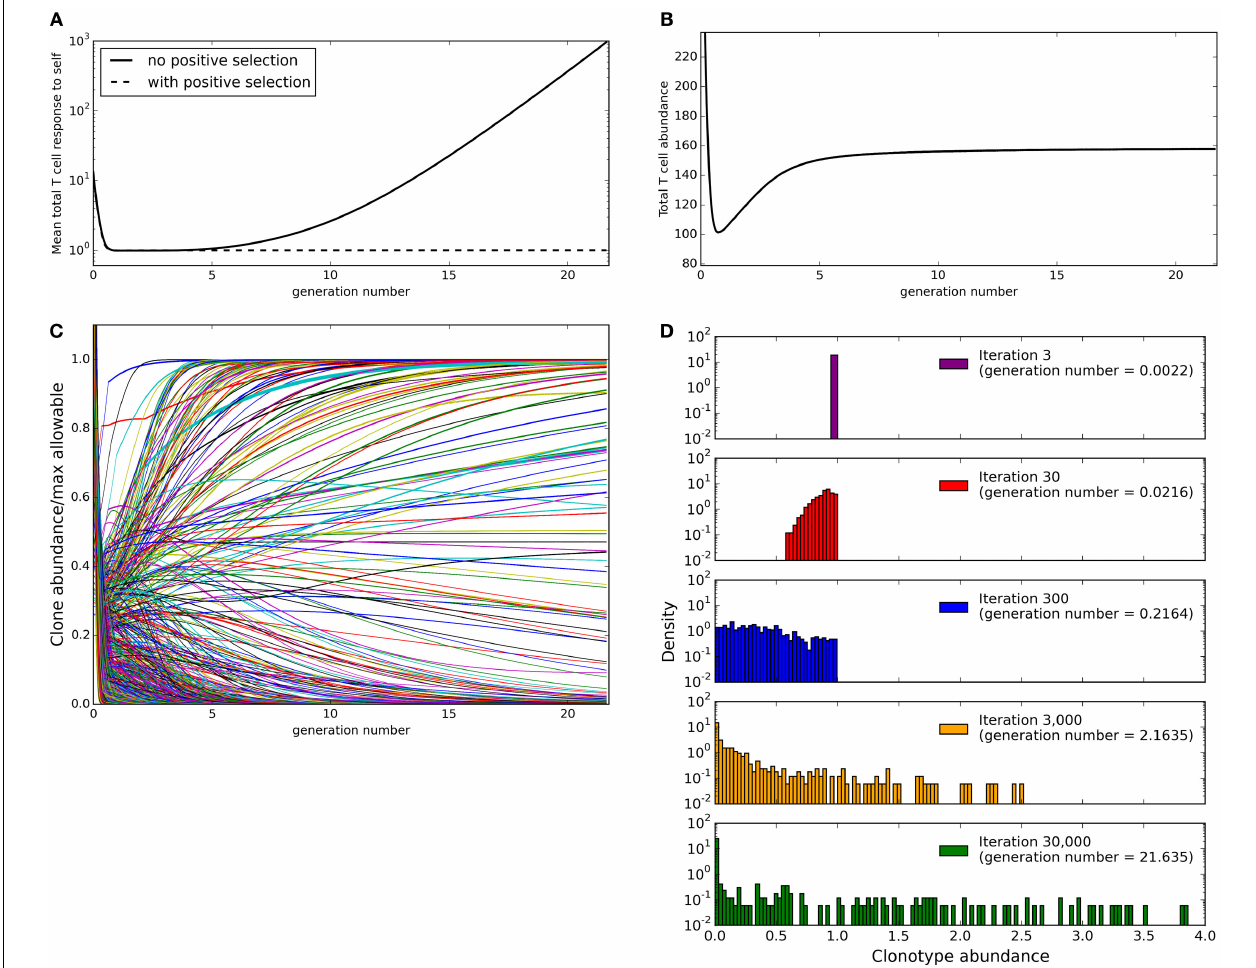
FIGURE 2 | Evolution of the repertoire under the constraints of dendritic cell dependent T cell deletion . (A) mean total T cell response to spMHC profiles over time as clone sizes are updated according to the basic immune-tolerance learning algorithm with or without positive selection implemented. The total T cell response to a profile is calculated as the sum of abundance (cid:2) binding strength for each clonotype. (B) the total T cell abundance (being the sum of the abundances of clonotypes present at a particular time) in the simulation after T cell positive selection is implemented